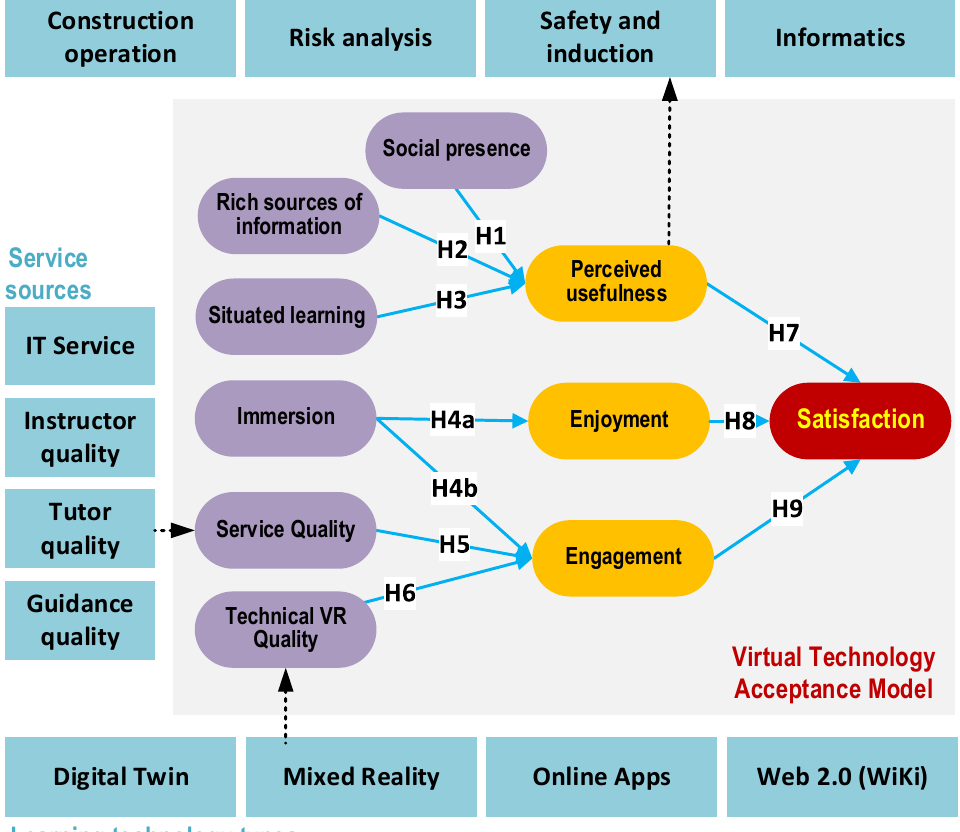
Figure 16. A proposed theoretical virtual technology acceptance model developed based on interviews, for measuring VR acceptance by